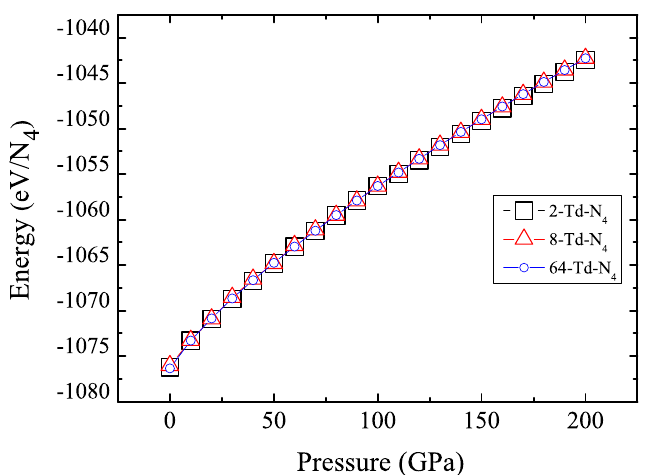
Figure 4. Energy as a function of pressure for the 2-Td-N 4 , 8-Td-N 4 and 64-Td-N 4 . Black square represents 2-Td-N 4 , red triangle represents 8-Td-N 4 , and blue circles represent 64-Td-N 4 .